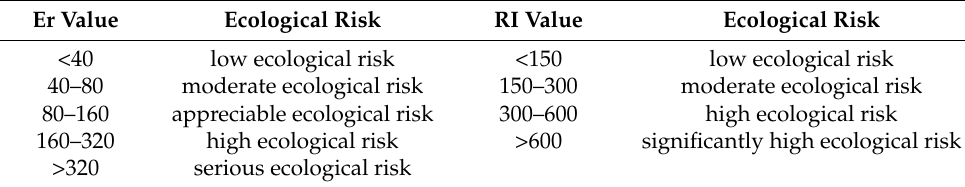
Table 3. The potential ecological risk index factor Eir and potential ecological risk index